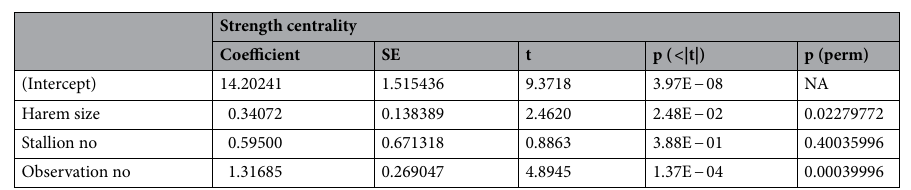
Table 3. The result of the regression analysis on the strength centrality of harems. p ( <|t|) is based on the t value as a normal consequence of linear regression without permutation and p (perm) is calculated based on the